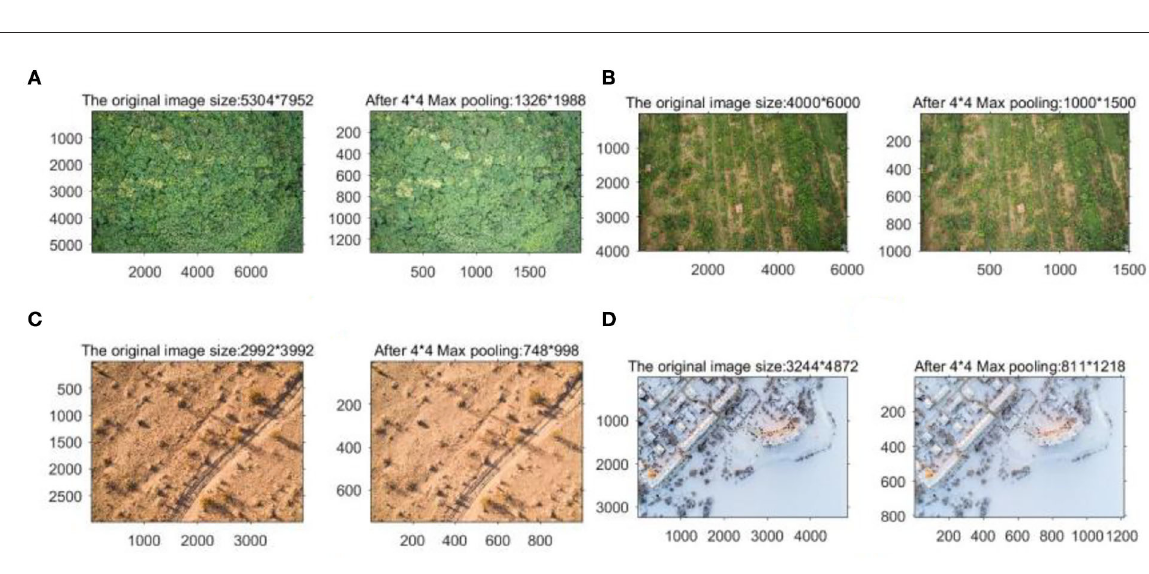
FIGURE7 Before and after pooling comparison: (A) woodland background; (B) grass background; (C) snow background; and (D) desert